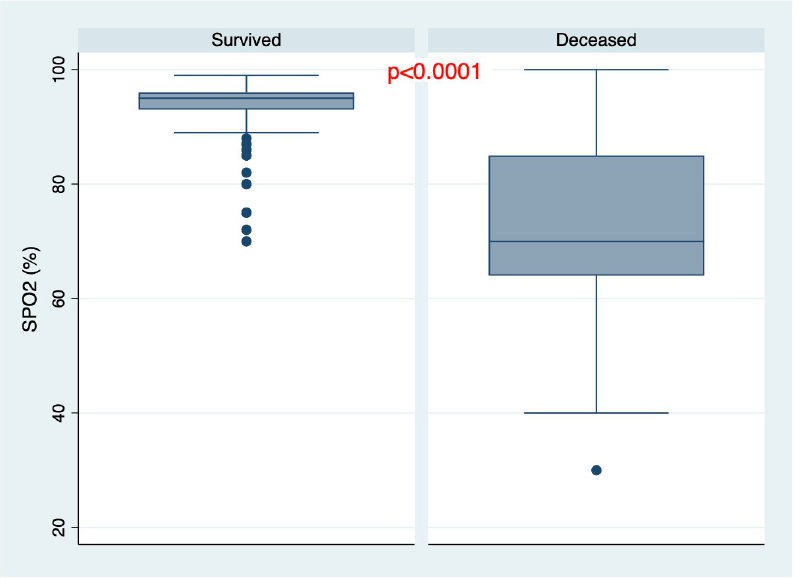
Fig 2. Saturation percentage among survived and deceased